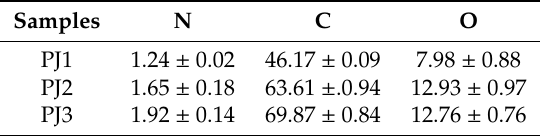
Table 1. Wavelength Dispersive X-ray Spectroscopy (WDS) measurements of the compositions in wt.% of PJ1, PJ2, and PJ3.